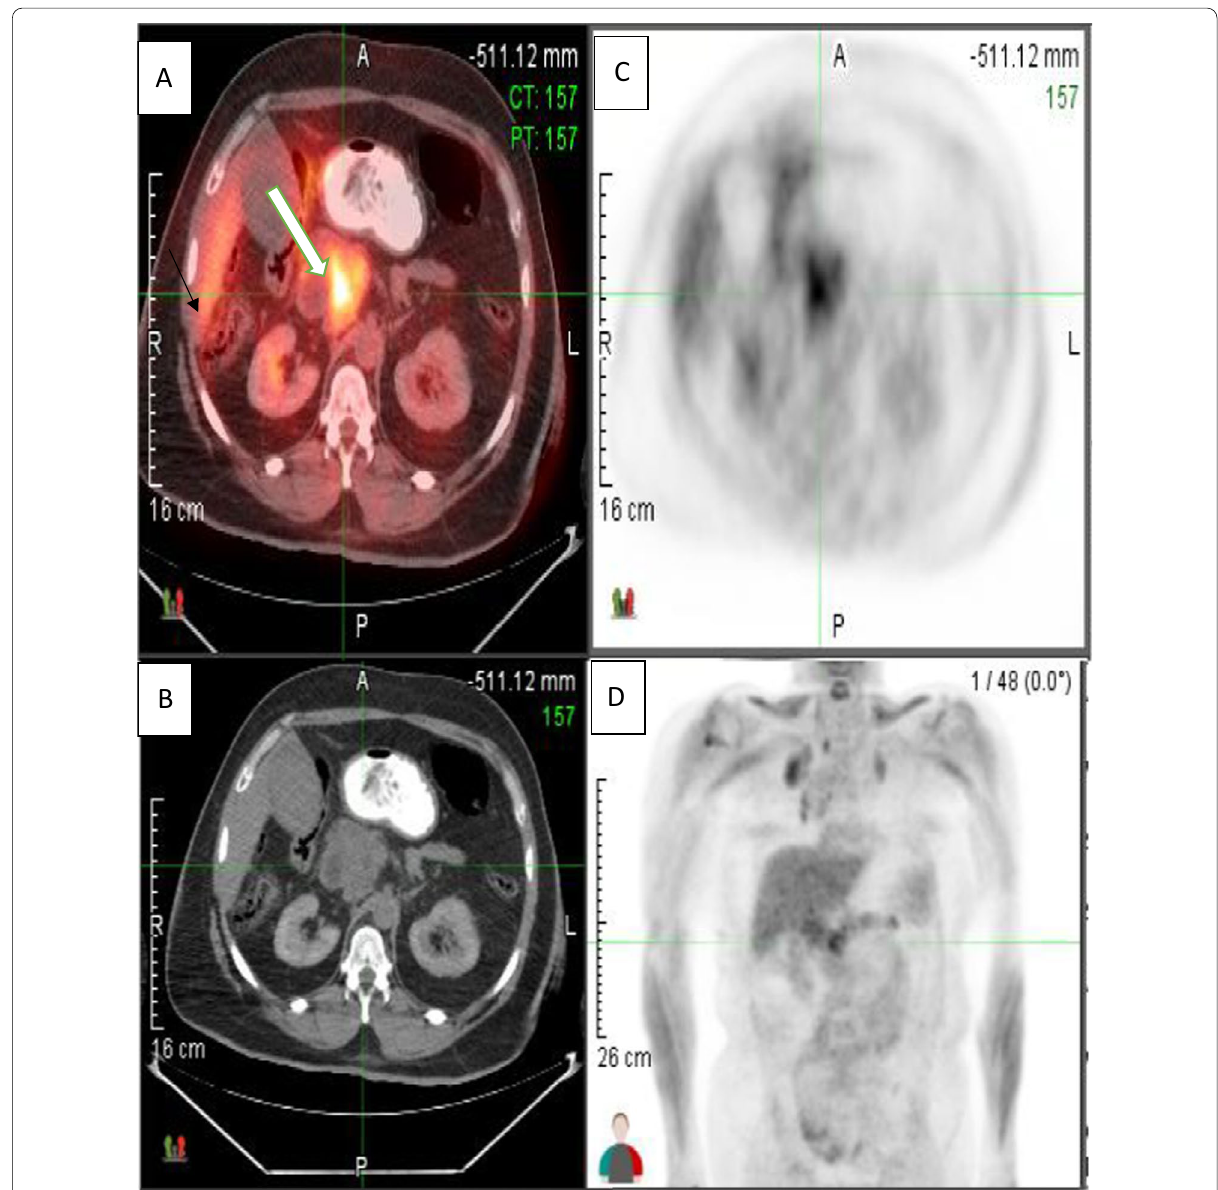
Fig. 1 56-year-old male patient with 4 4 cm pancreatic head FDG avid mass with SUVmax 3.9 (white block arrow) G3PNET which is × histopathologically proved.In addition, there is slightly accentuated activity with SUVmax 2.4 in the inferior right hepatic lobe potentially represent liver metastasis (black arrow). A Fused Axial PET/CT, B Axial CT, C , D